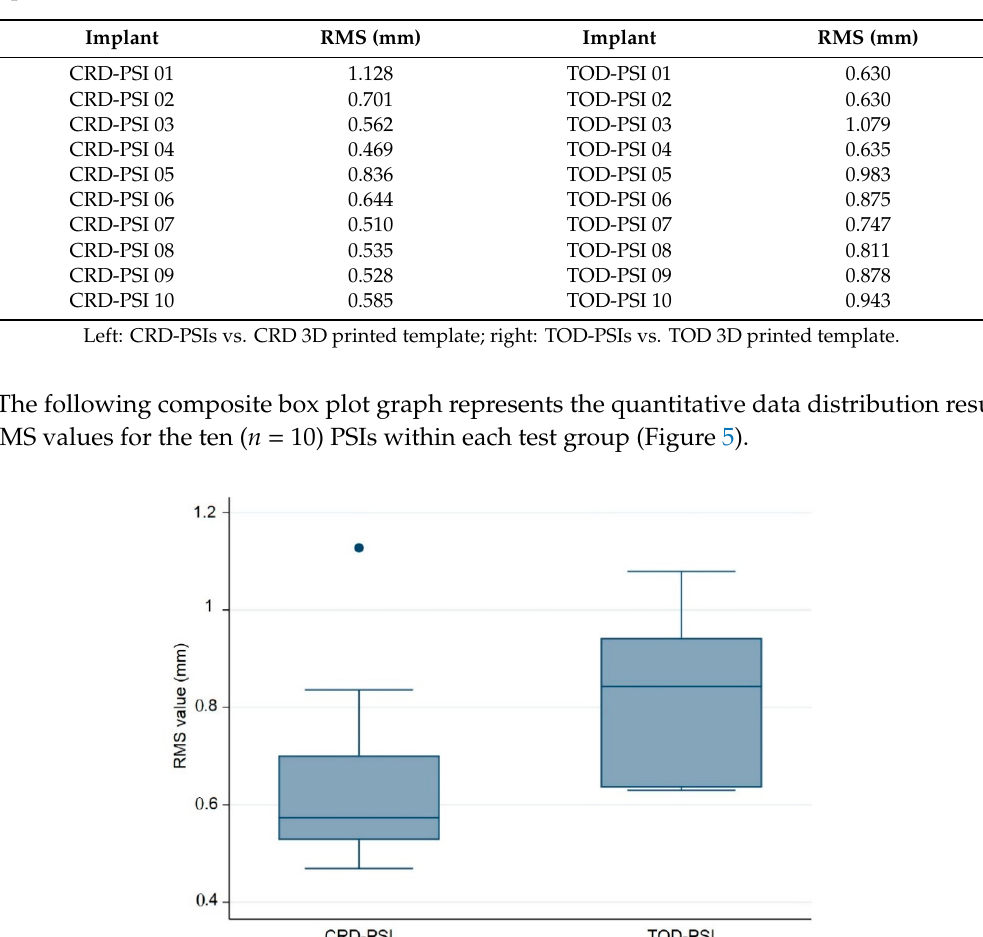
Table 4. Quantitative accuracy assessment for the median RMS values (mm) in the CRD-PSIs and TOD-PSIs. Implant